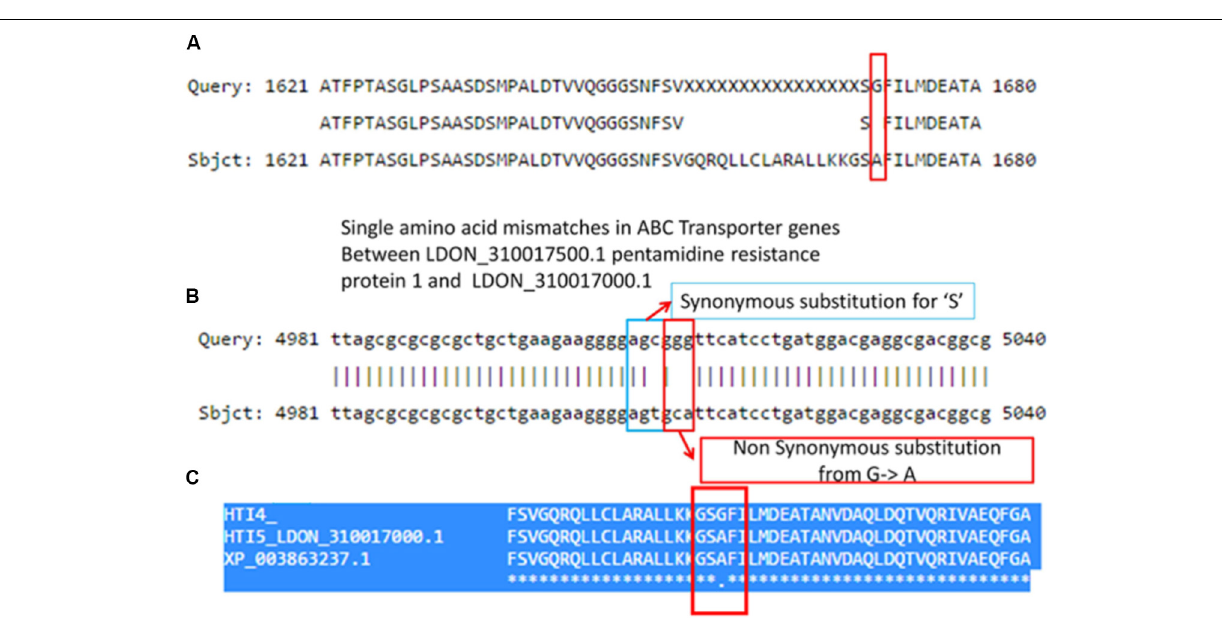
paraflagellar rod protein 1D (PFR 1D) was over expressed in